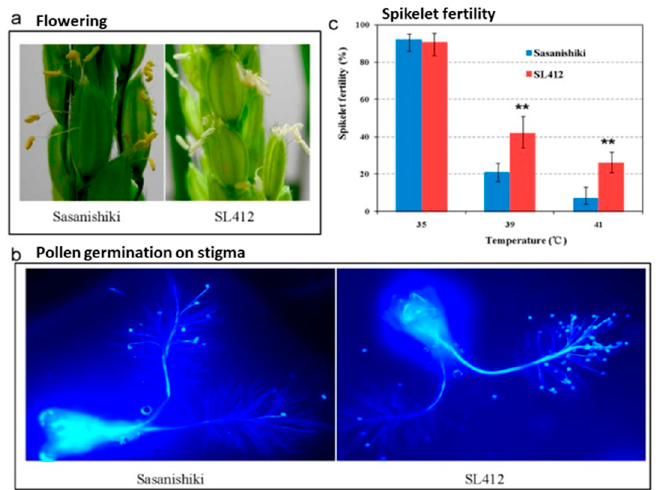
Figure 2. Heat tolerance of heat-sensitive japonica (Sasanishiki) and tolerant CSSL line (SL412) at high temperature showing the ( a ) flowering, ( b ) pollen germination, and ( c) spikelet fertility [107].